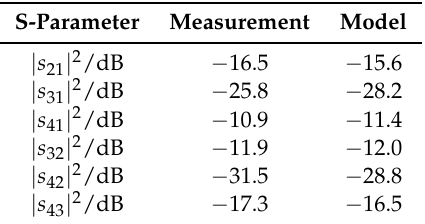
Table 2. Transmission coefficients of the four-channel coil array at f = 123.2MHz.